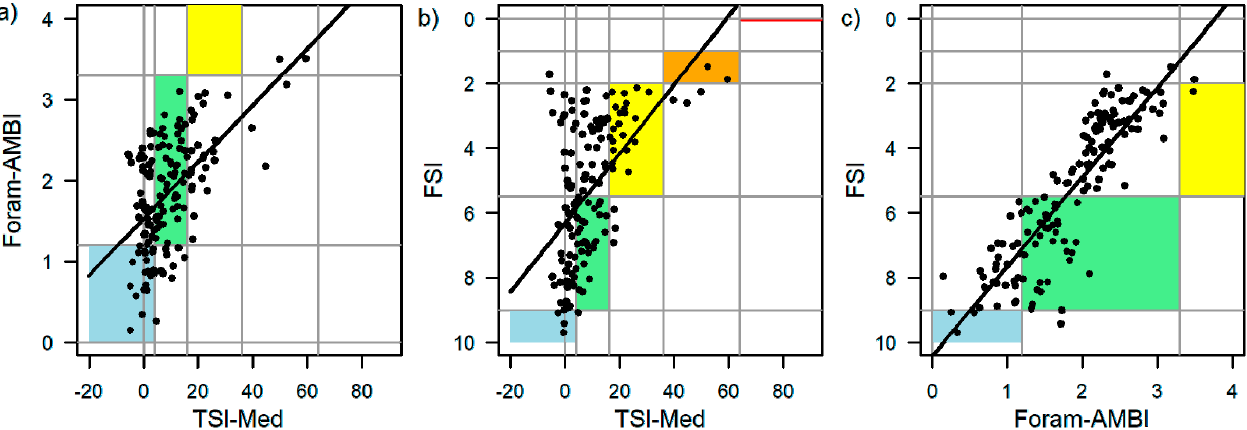
Figure 3. Quality indices based on groups of indicator species compared two by two. ( a ) Foram-AMBI vs. TSI-Med, ( b ) FSI vs. TSI-Med, ( c ) FSI vs. Foram-AMBI. Information on linear regressions is summarised in Table 4. For all comparisons, the original ecological assignments have been used. For FSI and Foram-AMBI percentages have been calculated after omitting unassigned taxa. The grey horizontal and vertical lines represent the Ecological Quality Status limits presented in Table 1. Coloured rectangles correspond to the areas were both indices have the same EQS: blue, “very good”; green, “good”; yellow, “moderate”; orange, “poor” and red, “bad”. The scale for FSI is reverse so that the environmental quality scale is in the same direction for each index.